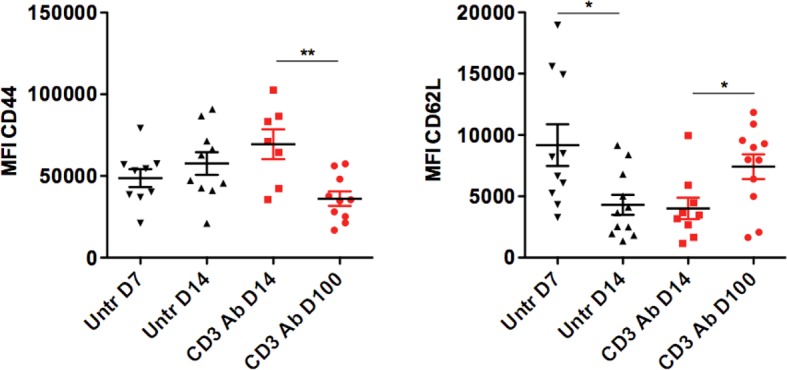
Mean fluorescence intensity of CD44 and CD62L expressed by intragraft CD8+ T cells after CD3 Ab therapy.